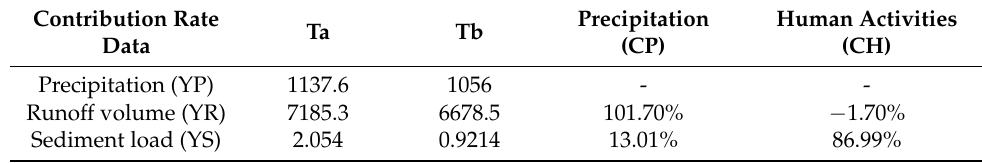
Table 7. Contribution rates of precipitation and human activities to runoff and sediment load at Hankou station in different periods (billion